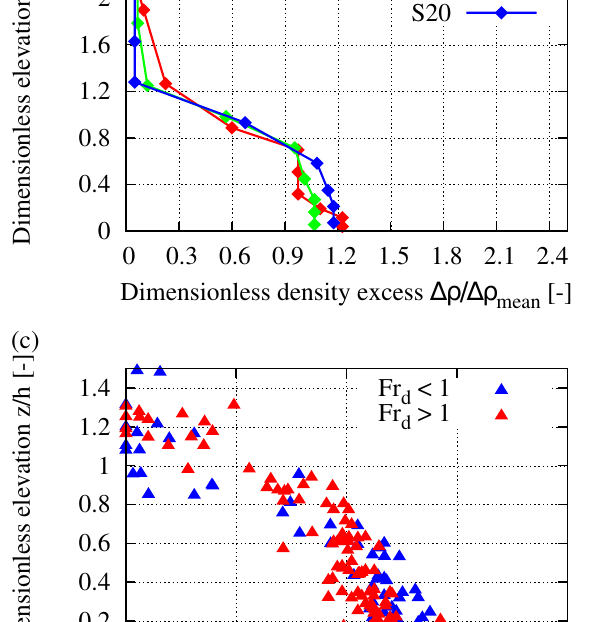
Figure 10. Density profiles: comparison between a saline current (experiment S14) and a turbidity current (experiment S25), mea- sured in cross section C5. The black triangles indicate the flow in- terface level of each current.